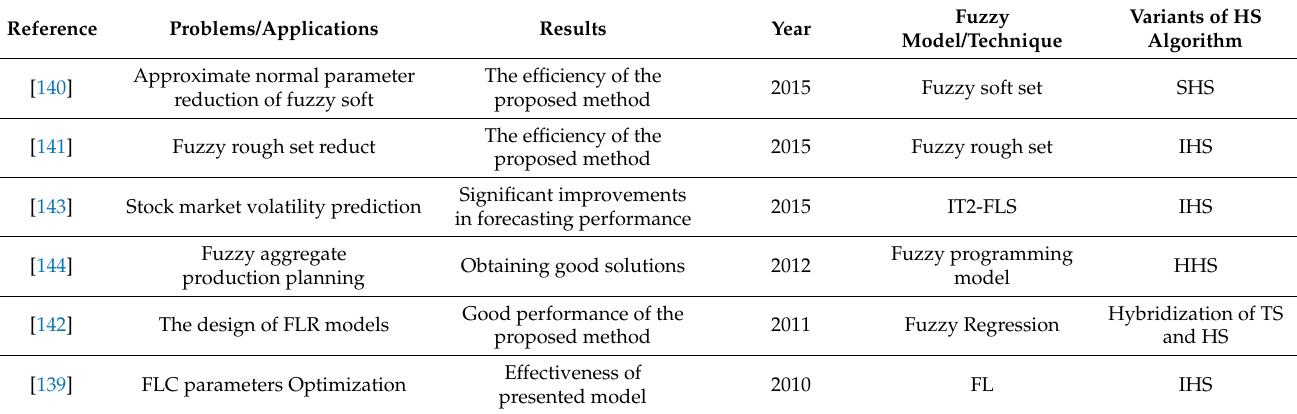
Table 5. A summary of the HS-based studies that focus on optimizing FL systems.